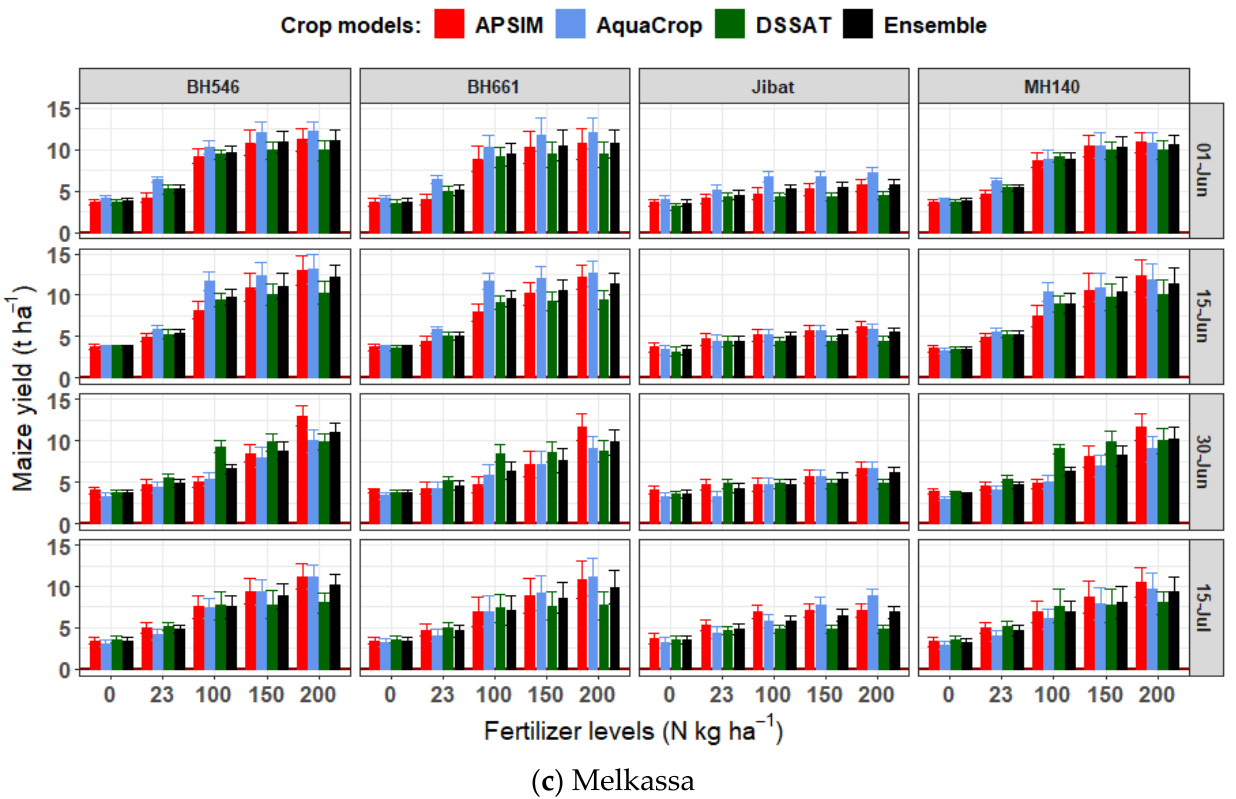
Figure 4. Maize yield (t ha − 1 ) with observed climate data for the baseline period (1995–2017) as simulated with APSIM, AquaCrop, and DSSAT models using different planting dates, cultivars, and nitrogen fertilizer levels for ( a ) Ambo (high altitude), ( b ) Bako (mid-altitude), and ( c ) Melkassa (low altitude). Error bars show the standard deviation of maize yield simulated by the crop models.